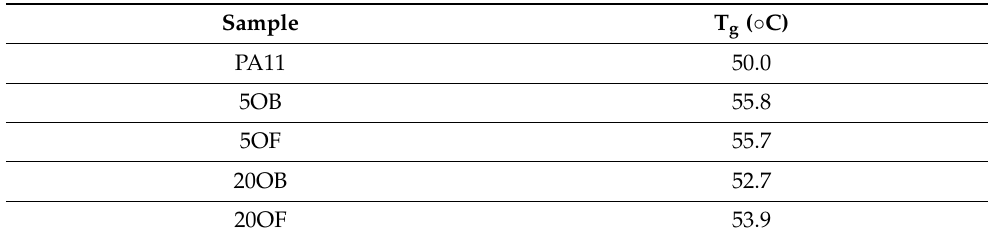
Table 7. Summary of the determined values of the glass transition temperature from storage modulus E’